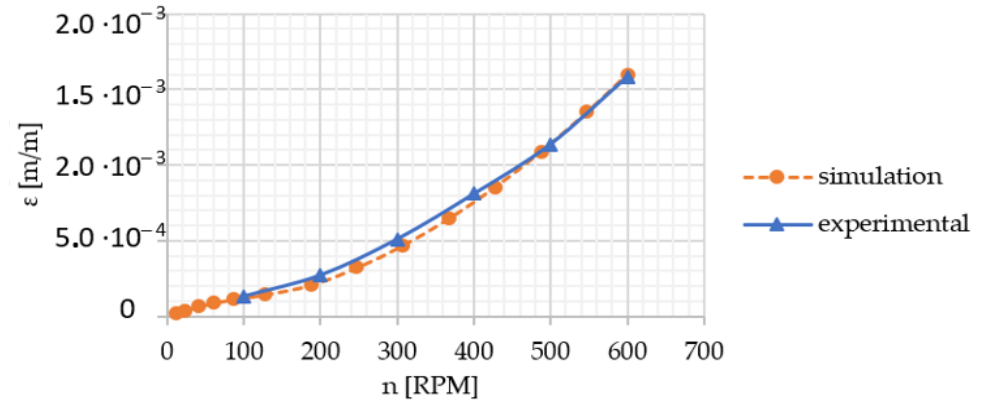
Figure 8. Strain curves for the strain gage at the root.